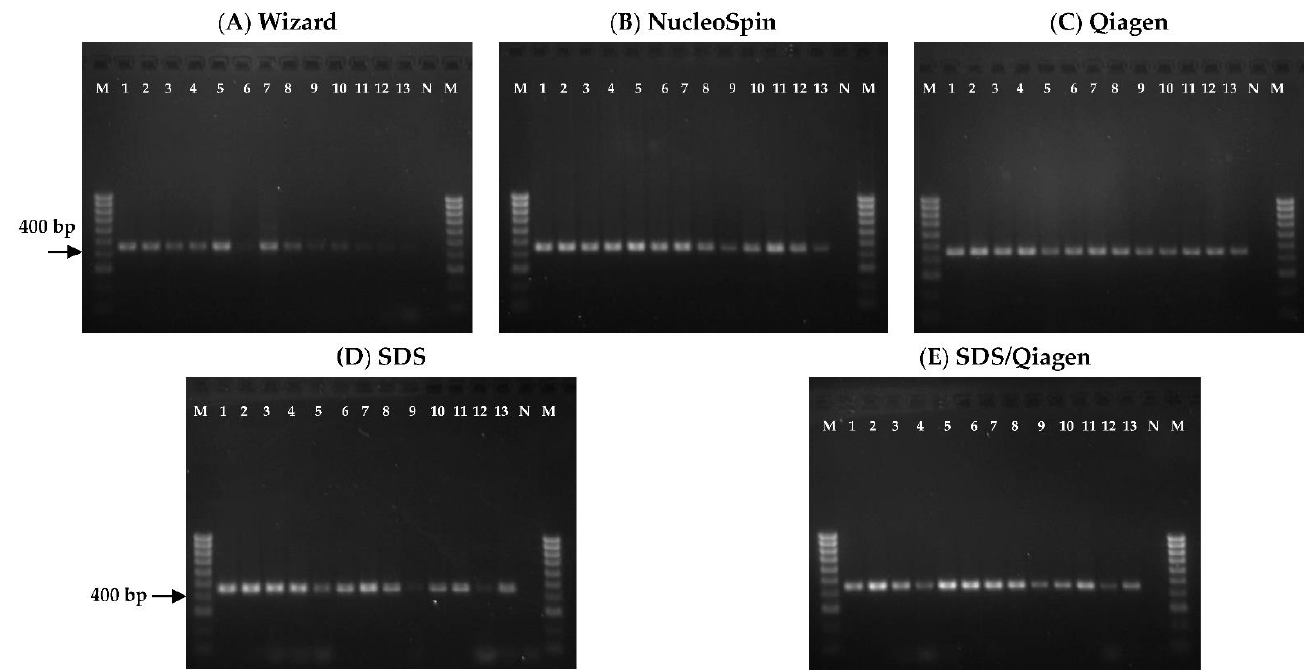
Figure 3. Gel electrophoreses of the 406 bp PCR products of cytochrome b gene amplified from extracted DNA of EBN samples with five different DNA extraction methods, namely ( A ) Wizard method, ( B ) NucleoSpin method, ( C ) Qiagen method, ( D ) SDS method and ( E ) hybrid SDS/Qiagen method. Lane M, 100 bp DNA ladder; lane 1–11, unprocessed EBNs; lane 12–13, processed EBNs; lane N, no template control. Table 2. Evaluation of five different DNA extraction methods using simple additive weighting technique. DNA